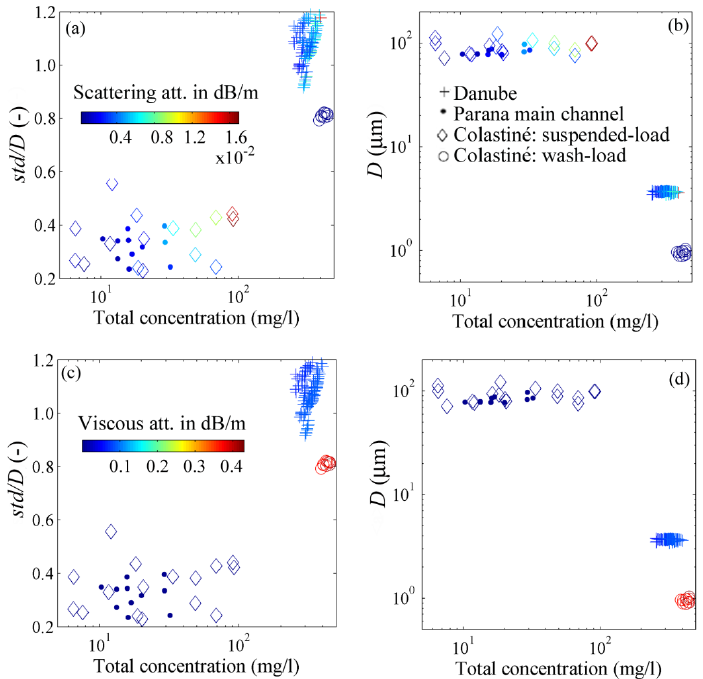
Figure 11. Assessed scattering attenuation coefficient among samples ( a ) for changing concentration and standard deviation over corresponding mean size ratio, std/D , and ( b ) for changing concentration and mean size, D ; Assessed viscous attenuation coefficient among samples ( c ) for changing concentration and standard deviation over corresponding mean size ratio, std/D , and ( d ) for changing concentration and mean size, D .